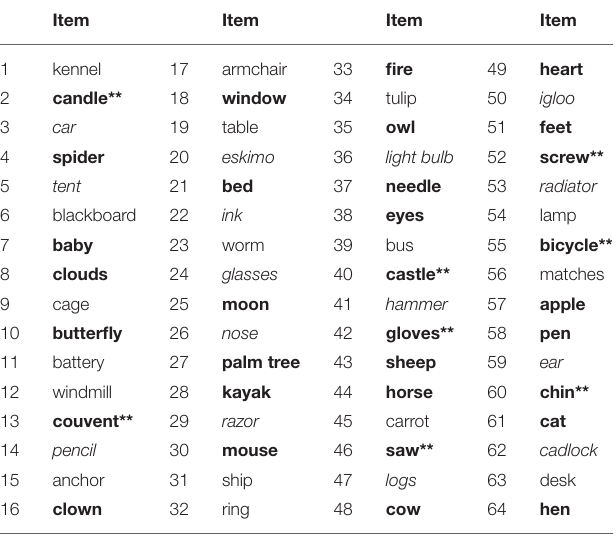
TABLE 3 | List of the stimuli included in the recognition task of the